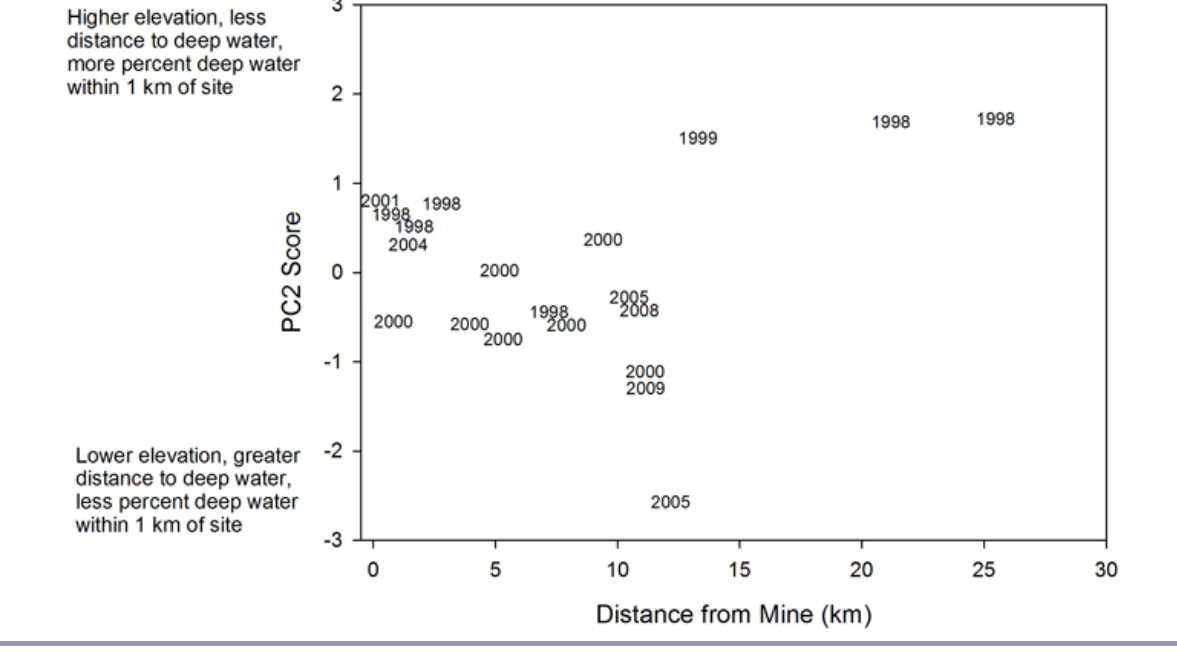
Fig. 2 . Spatial distribution of nest site quality relative to distance from the Ekati and Diavik diamond mines in the Lac de Gras study area. Elevation above sea level, distance to deep water, and percent deep water within a 1 km radius of nest sites were considered as suitability attributes. Values for each nest site in the study were derived from the second principal component (PC2). Observation labels indicate the year the nest site was detected and monitoring began